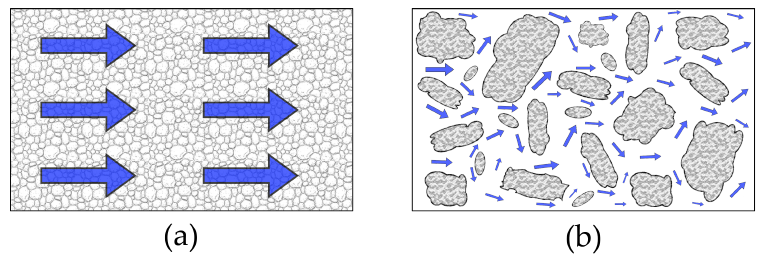
Figure 4. Representation of different flow regimes through porous media. Where ( a ) shows laminar flow through uniform small-grained material and ( b ) demonstrates turbulent flow condition through material with coarser grains and larger